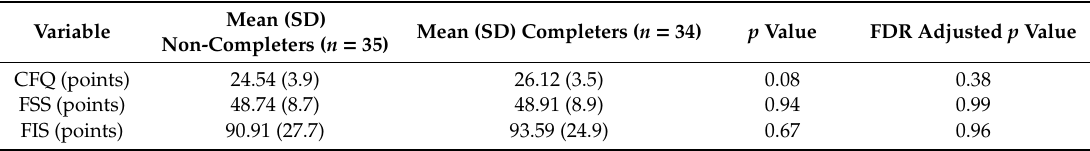
Table 2. Comparison of completers vs. non-completers in fatigue before